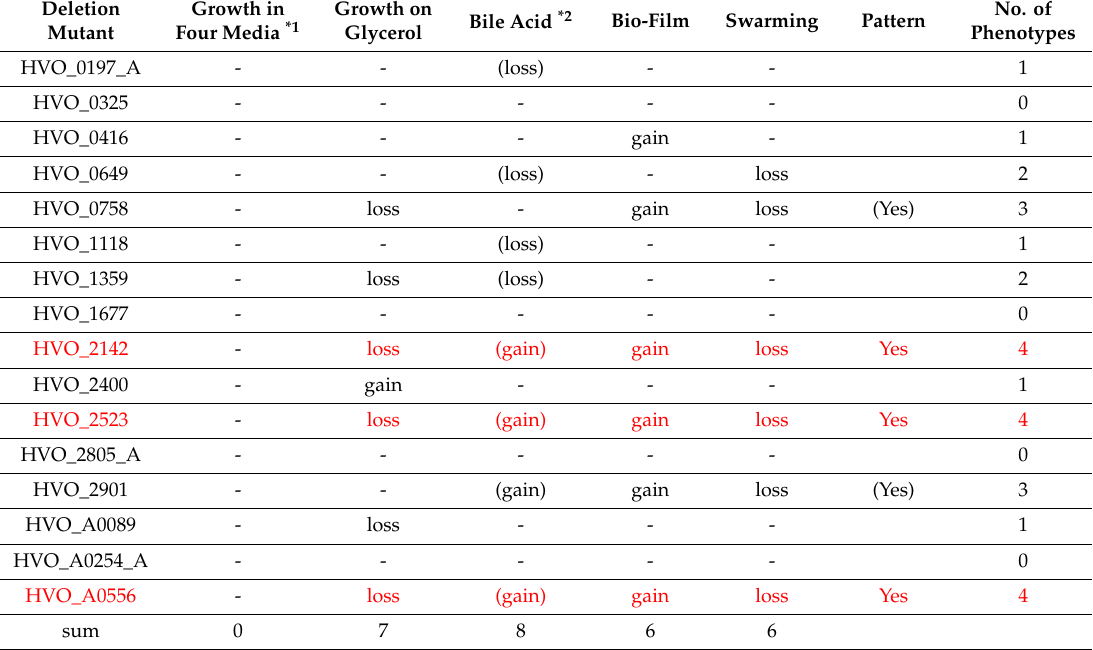
Table 2. Summary of phenotypic analysis of 16 zinc finger gene deletion mutants. “-” indicates that wild-type and deletion mutant are indistinguishable, “loss” indicates a loss of function phenotype of the mutant, “gain” a gain of function phenotype. Three mutants with the same pleiotrophic phenotype are shown in